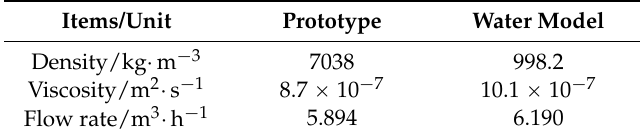
Table 2. Physical properties of fluids and parameters of water